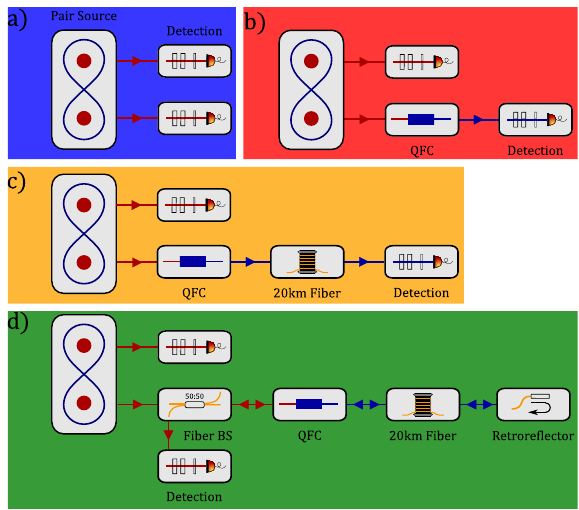
Fig. 5 Overview of the different experimental con fi gurations. a The output state is measured directly at the source. b One of the photons is frequency-converted before its detection. c 20 km of fi ber is inserted between conversion and detection. d The 20 km fi ber gets terminated with a retro-re fl ector. The back re fl ected photons get back-converted after 40 km of fi ber and are extracted with a 50:50 fi ber beamsplitter before their detection. The background colors correspond to the colors of the data points in Fig.